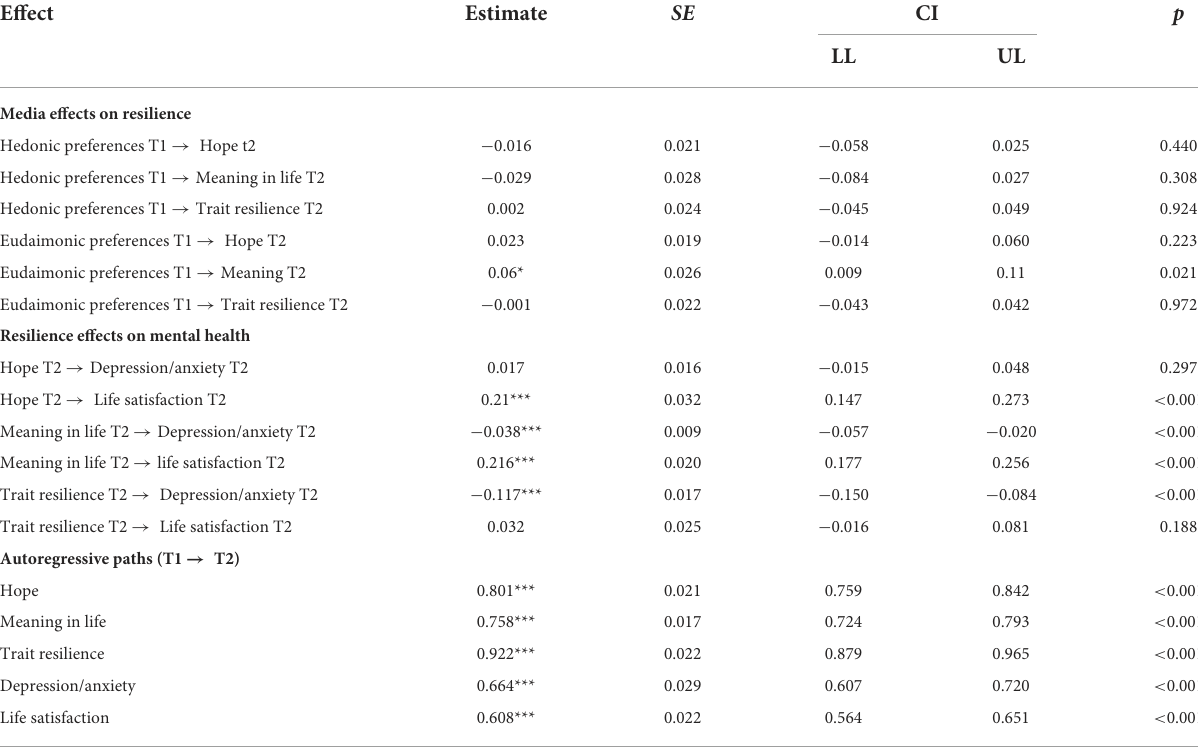
TABLE 2 Results of the pre-registered structural equation model testing H1–4 and